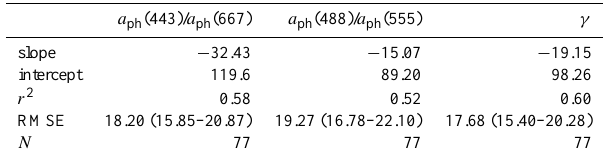
Table 3. Regression coefficients and determination coefficients ( r 2 ) between F L and IOPs, a ph (443)/ a ph (667), a ph (488)/ a ph (555), and γ . All p -values were less than 0.01. RMSE are also pro- vided. Values in parentheses are 95% confidence intervals of each RMSE, which were computed assuming exponential distribution to the square